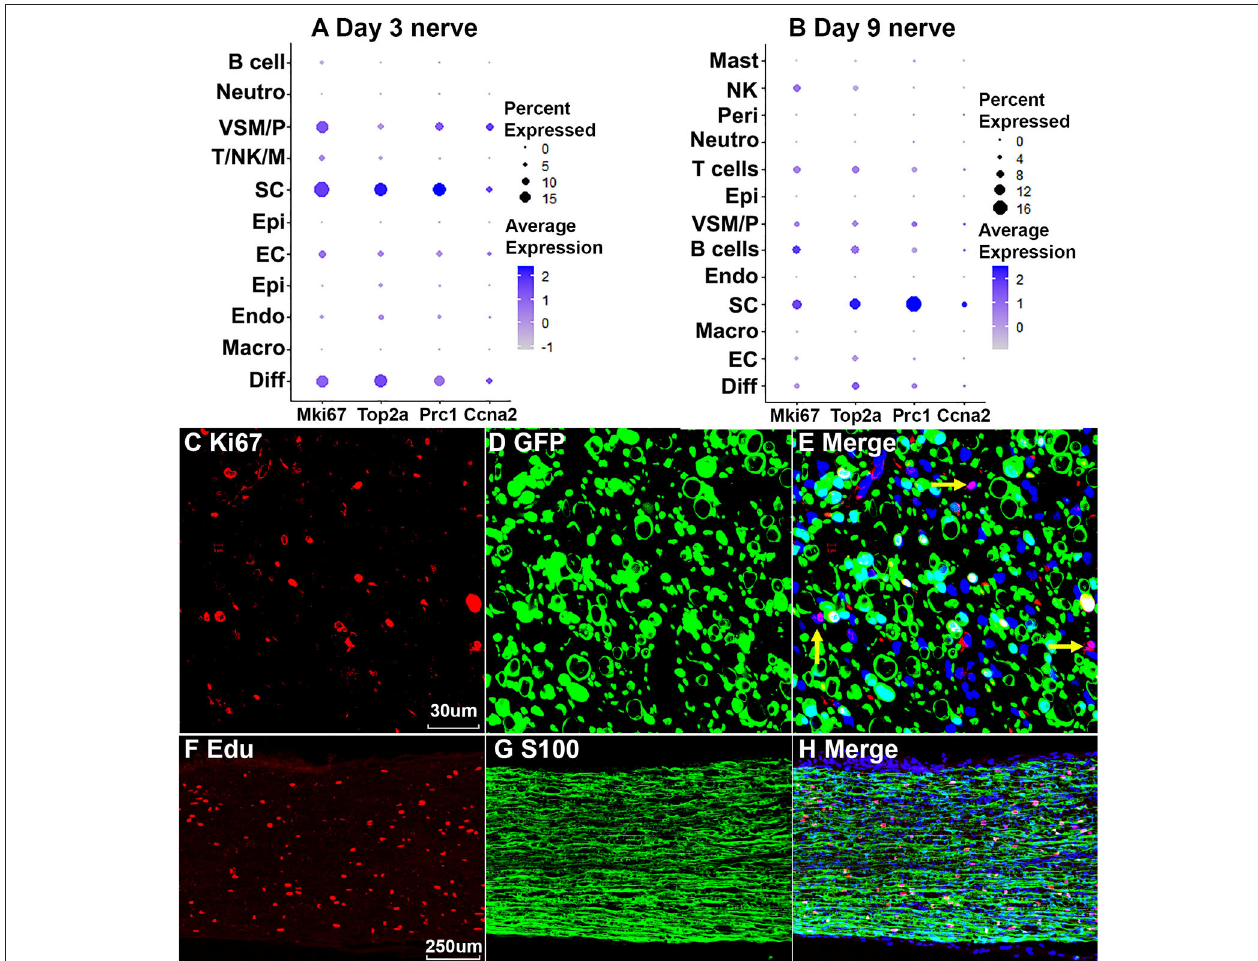
FIGURE 9 | Proliferating cells in the injured peripheral nerves. (A) Marker genes Mki67, Top2a, Prc1, and Ccna2 identify Schwann cells as the most proliferative cells in the distal nerve at day 3 post injury. (B) Mki67, Top2a, Prc1, and Ccna2 identify Schwann cells as the most proliferative cells in the distal nerve at day 9 post injury. (C–E) Mki67/Ki67 staining showing Schwann cells (GFP positive) are the most proliferative cells in the distal nerve at day 7 post injury in PLP-GFP mice. Yellow arrows in (E) show proliferation of non-Schwann cells (GFP negative). (F–H) EdU labeling showing that Schwann cells (S100 positive) are the most proliferative cells in the distal nerve at day 7 post injury in C57 mice. Scales bar in (C) 30, in (F) 250 µ m.